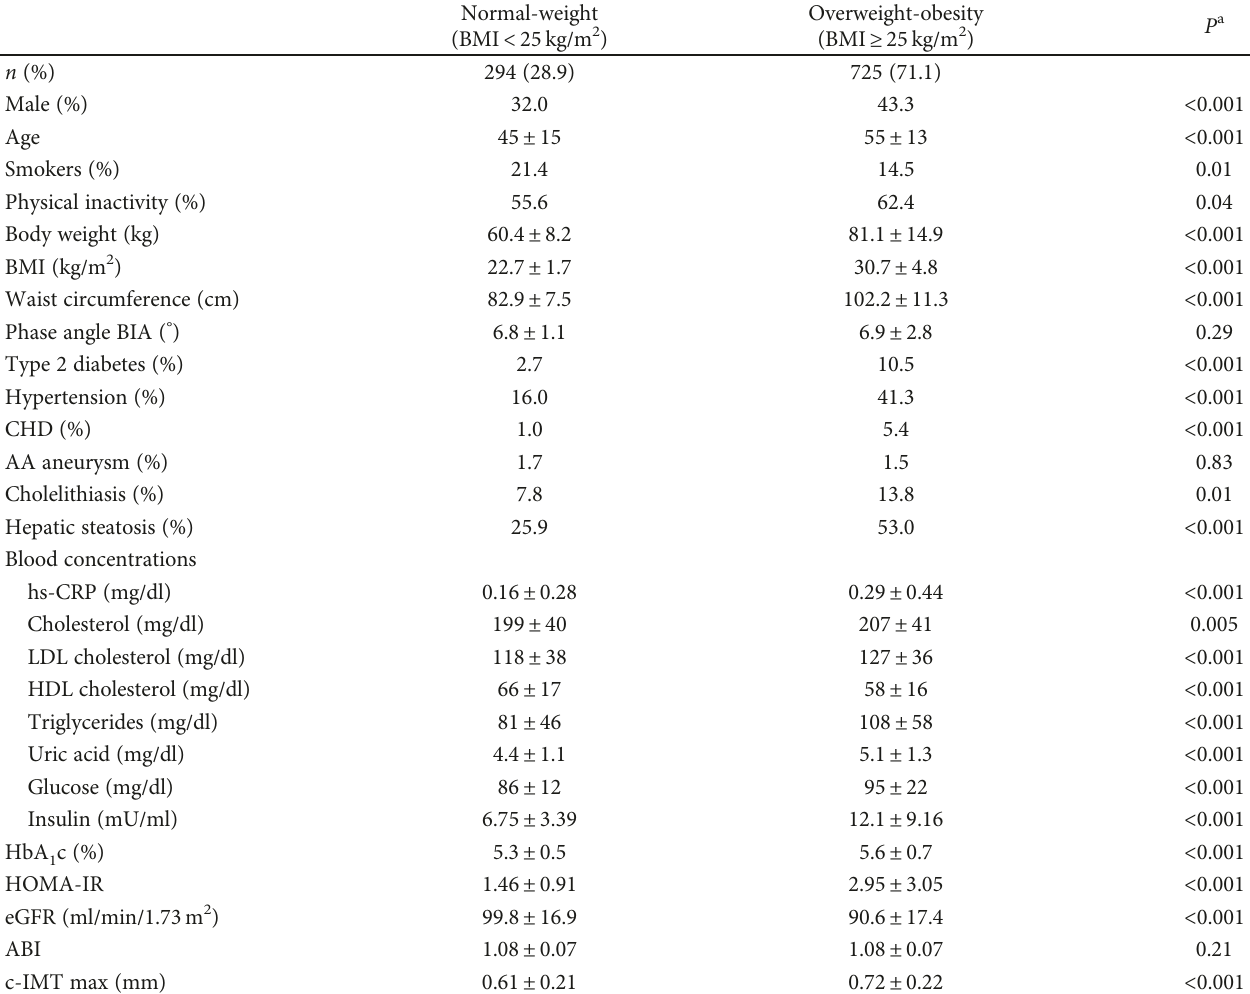
Table 3: Physical and biochemical characteristics of the cohort divided according to the presence of overweight-obesity.